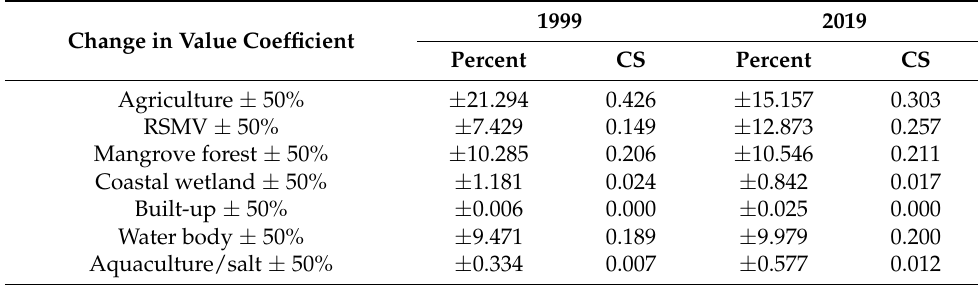
Table 5. Total approximate ecosystem services and coefficient of sensitivity (CS) in CRB after changing the ES valuation coefficient (VC) from 1999 to